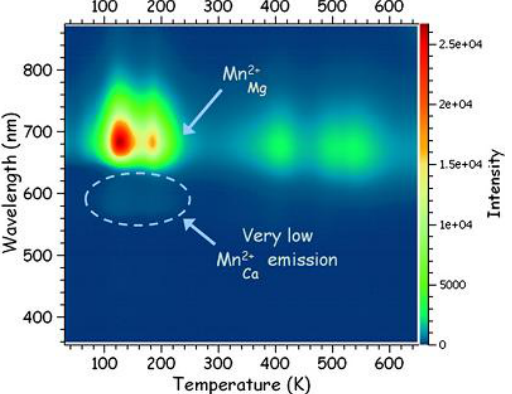
Figure 5. Thermoluminescence (TL)-emission mapping: the emission spectrum is monitored during the thermoluminescence experiment, showing which traps are related to which activators.